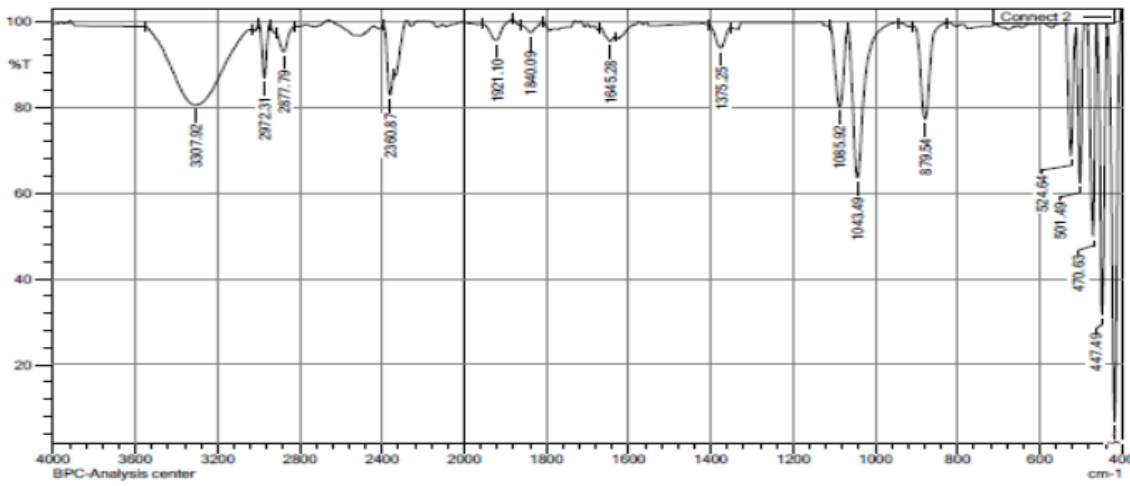
Figure 10. IR spectrum of isolated